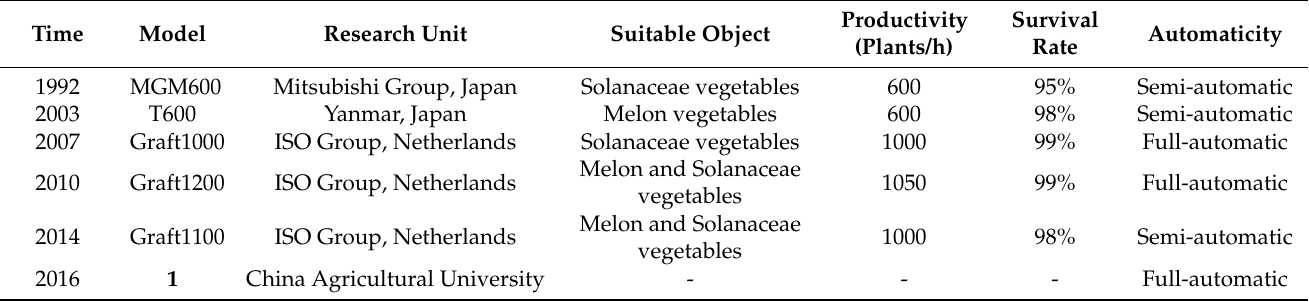
Figure 5. Graft1100 semi-automatic grafting robot developed by ISO Group. Table 2. Comparison of the Characteristics of the vegetable Grafting robots Based on Tube Grafting.